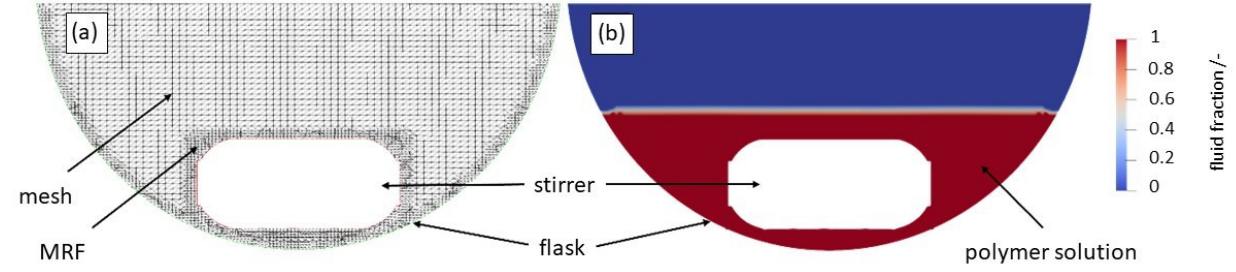
Figure 3. Generated mesh ( a ) and fluid phases ( b ) of the developed setup. The edges of the geometries are shown in colour (blue = piston and red = stirrer).